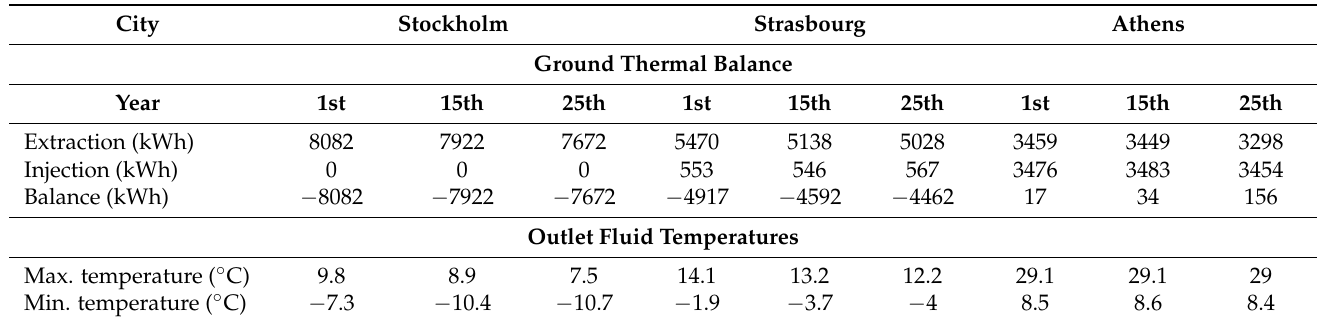
Table 10. Ground thermal balance and outlet BHE temperatures in the 1st, 15th, and 25th year for 3